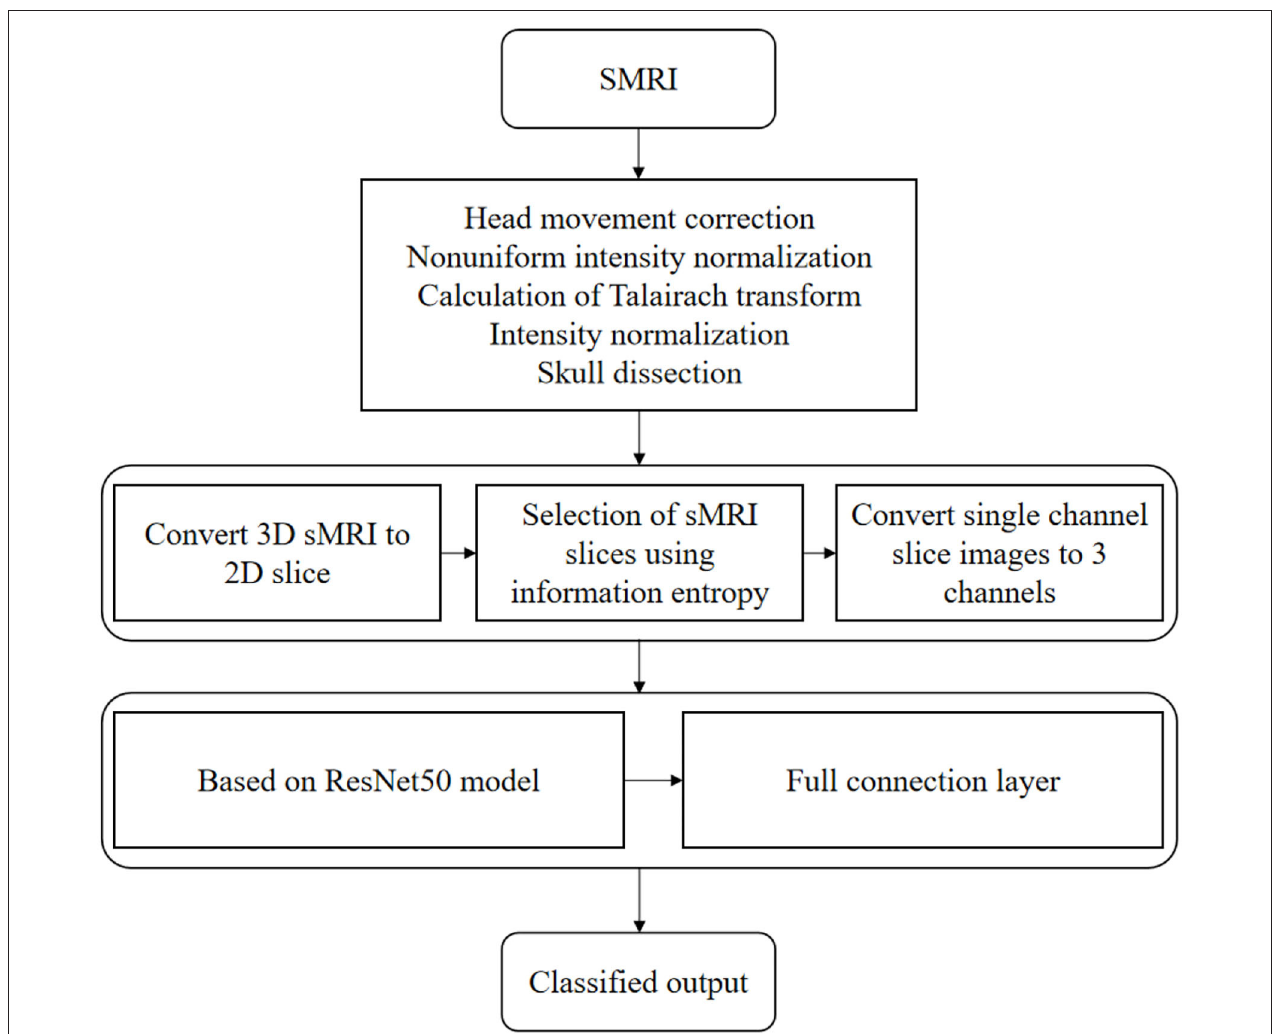
FIGURE 3 | AD classification algorithm flow